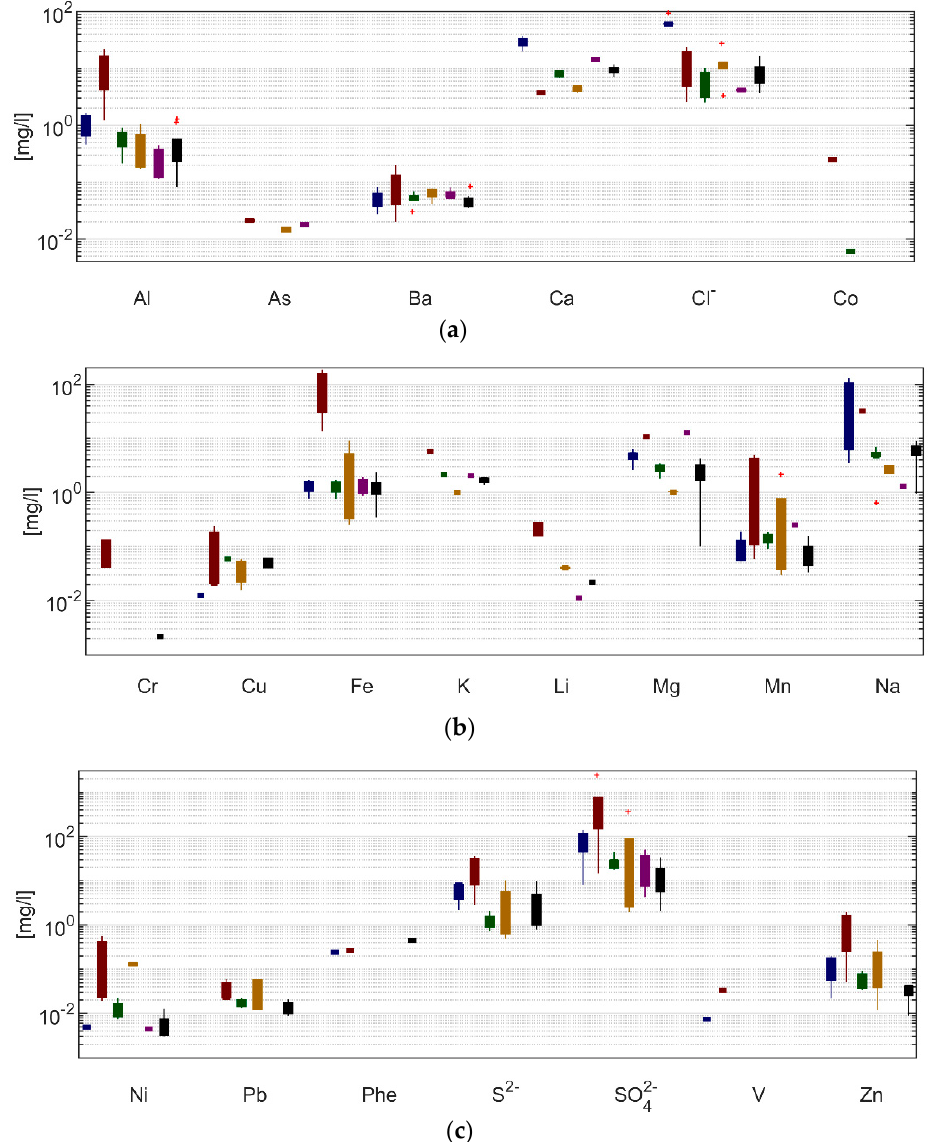
Figure 5. Spatial distribution of toxicants in water: ( a ) Al, As, Ba, Cl − and Co; ( b ) Cr, Cu, Fe, K, Li, Mg, Mn and Na; ( c ) Ni, Pb, Phenol, S 2 − , SO 42 − , V and Zn.